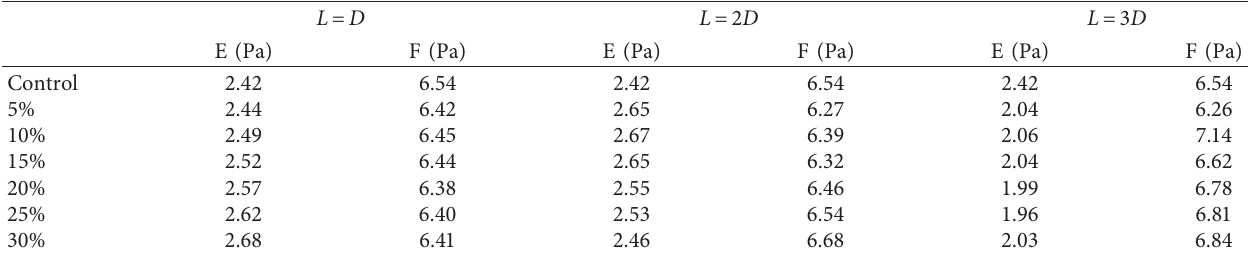
Table 6: Raw data of average wall shear stress at different locations (Groups E and